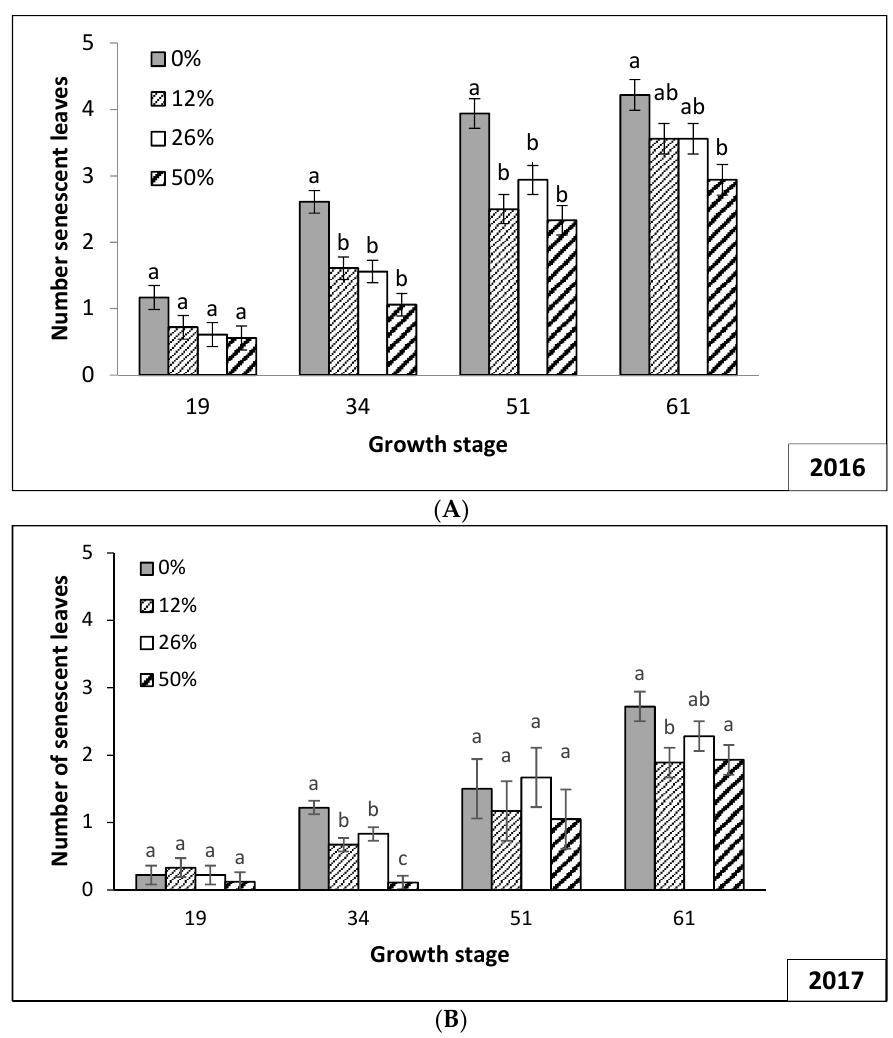
Figure 5. Number of senescent leaves per plant under the different shading levels at the growth stages 15 (5th leaf unfolded), 19 (9th or more leave unfolded), 34 (4 nodes detectable), 51 (tassel initiation), and 61 (silking) of the control in 2016 ( A ) and 2017 ( B ). Black bars represent the standard error of mean. Means with identical letters within a growth stage show non-significant differences between the shade levels (LSD, p < 0.05).